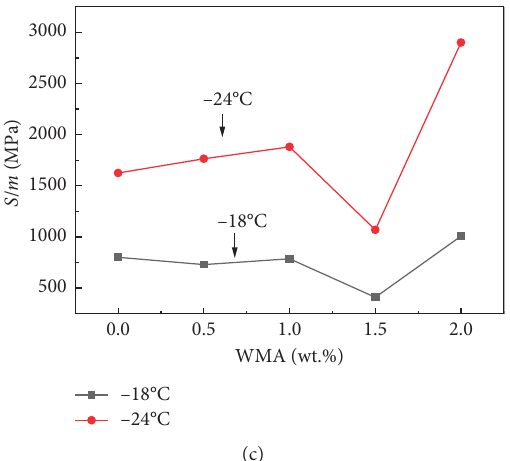
Figure 9: Evolution of S and m values versus loading time for warm-mix HVA at (a) − 18 ° C and (b) − 24 ° C, and (c) the ratio of creep stiffness S and m as a function of WMA content at − 18 and − 24 °